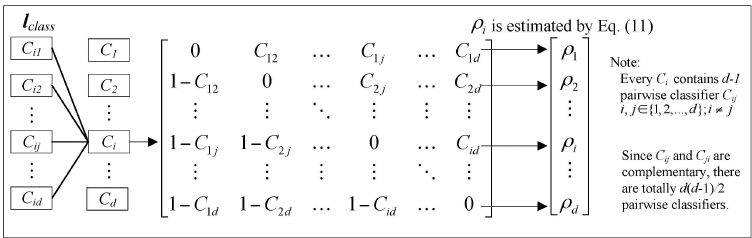
Figure 3. Pairwise coupling strategy of probabilistic